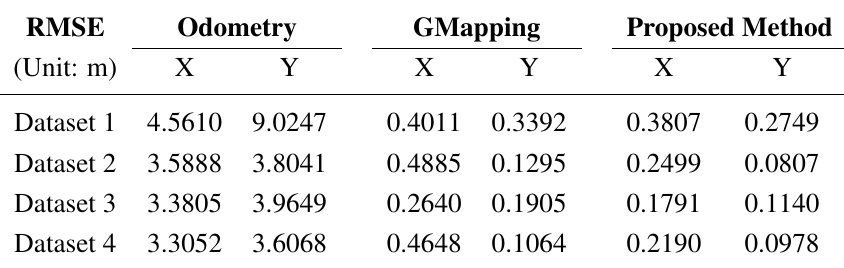
Table 3. RMSE results. The error of the odometry is the largest. The error of GMappingis smaller than that of the odometry, and the error of the proposed method is the smallest with respect to Datasets 1, 2, 3 and